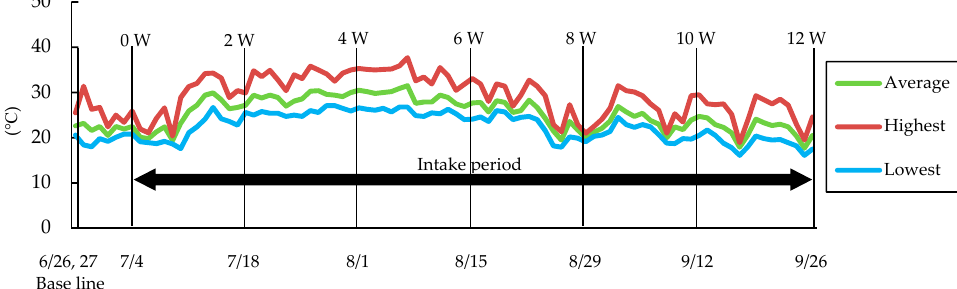
Figure 1. Temperatures in Tokyo during the study. Data were obtained from the meteorological agency in Japan.